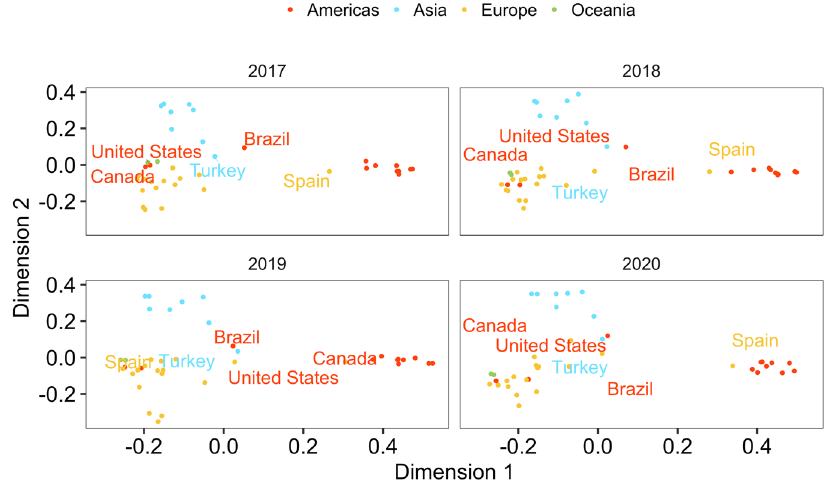
Fig. 2 Multidimensional scaling representation of charts distance. Jaccard distances calculated over annually constructed incidence matrices. Countries are colored according to the continent they belong to (red: Americas, yellow: Europe, blue: Asia, Green: